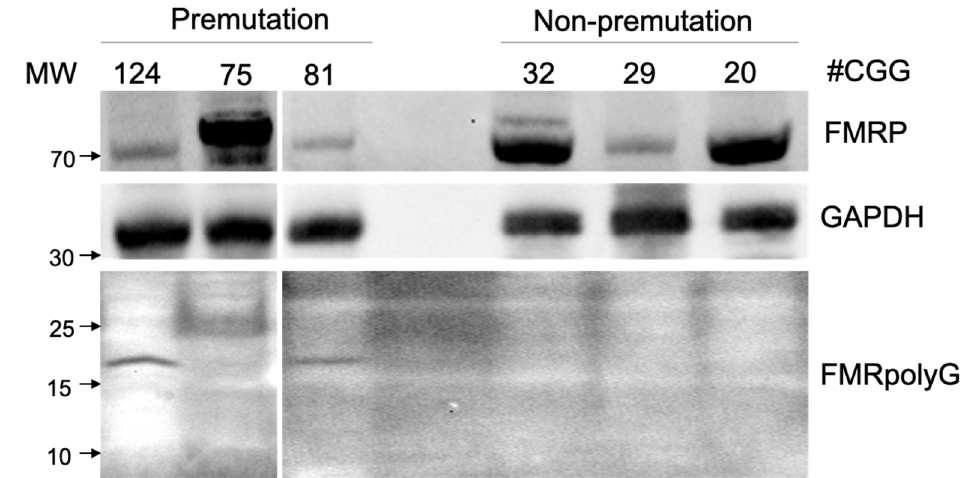
Figure 2. Fragile X mental retardation polyglycine (FMRpolyG) was detected in peripheral blood mononuclear cells (PBMCs) lysate from FMR1 gene premutation carriers and age-matched individuals. FMRpolyG was detected in two FMR1 premutation carriers (124 and 81 CGG repeats, respectively).